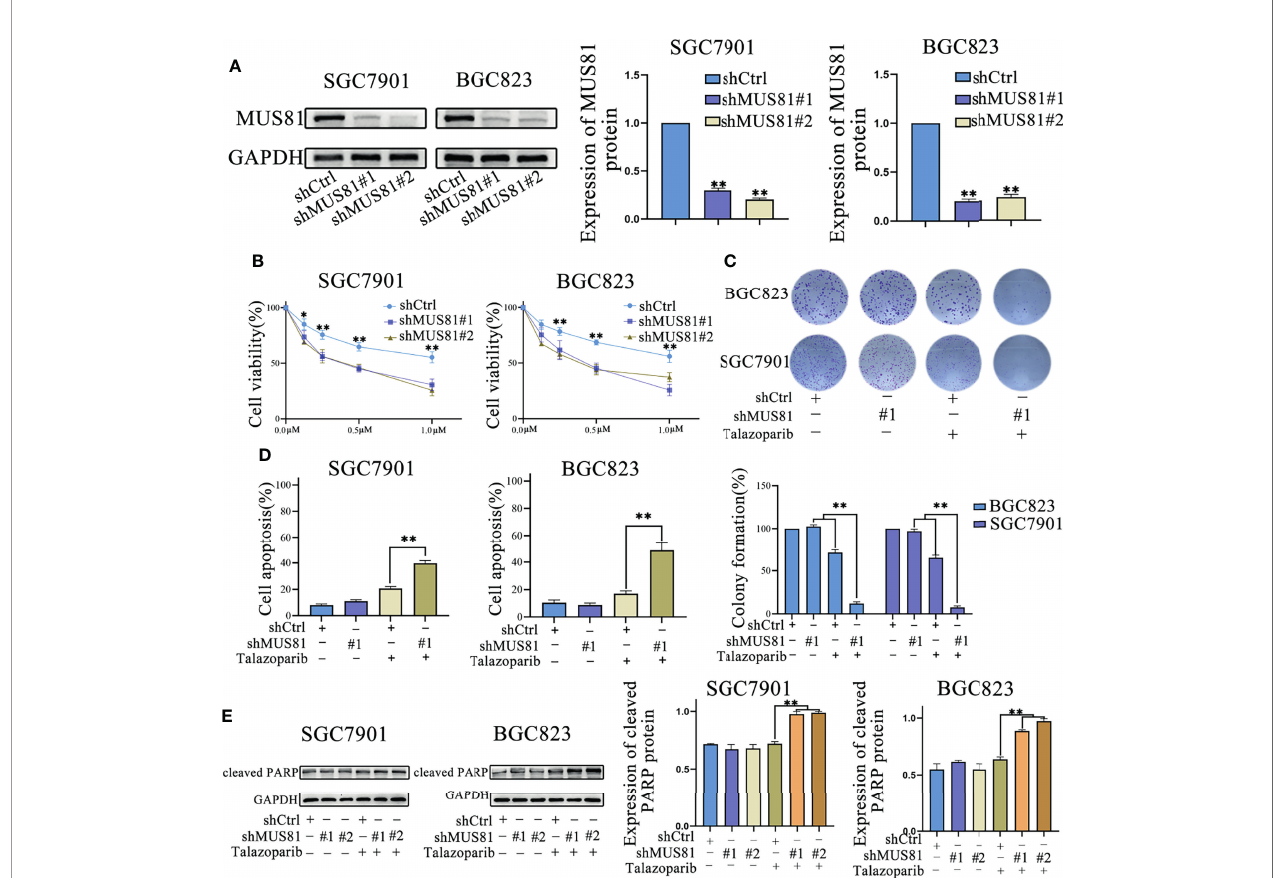
FIGURE 2 | MUS81 knockdown promotes apoptosis and talazoparib anticancer ef fi cacy in vitro . (A) Western blotting of MUS81 protein expression after transfection with the lentivirus expressing short hairpin RNA (shRNA) targeting the sequence of human MUS81 for 24 h. ** P < 0.01. (B, C) Viability of SGC7901 and BGC823 cells transfected with lentivirus expressing shMUS81 #1, shMUS81 #2 or shCtrl, as determined using MTS and colony formation assays (t-test). *P < 0.05. **P < 0.01. (D) Cells treated with DMSO or talazoparib (1 µmol/L) for 3 d to evaluate apoptosis by fl ow cytometry ( t -test). ** P < 0.01. (E) Expression of apoptosis-related proteins in SGC7901 and BGC823 cells treated with DMSO or talazoparib (0.5 µmol/L) for 24 h, as evaluated by western blotting ( t -test). ** P <